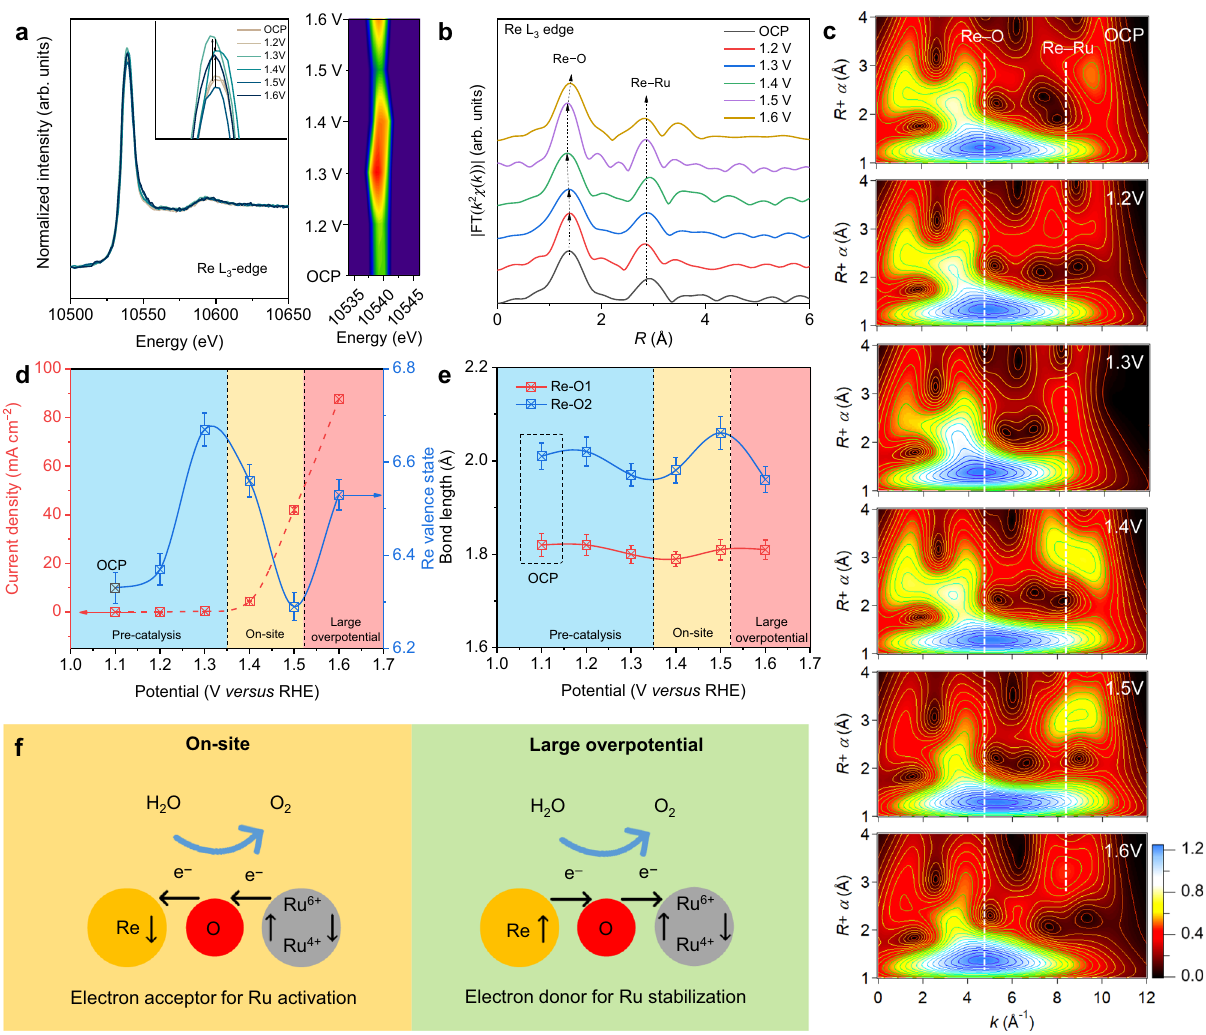
Fig. 3 | Operando XAS characterization of Re 0.06 Ru 0.94 O 2 con fi rming dynamic process. a Re L 3 -edge XANES spectra for Re 0.06 Ru 0.94 O 2 at differing potentials in O 2 -saturated 0.1M HClO 4 . Right part: contour plot of the Re L 3 -edge white peak intensity. b FT-EXAFS signals for Re 0.06 Ru 0.94 O 2 corresponding to ( a ). c Comparison of Re L 3 -edge WT-EXAFS plots for Re 0.06 Ru 0.94 O 2 from OCP to 1.6V. d Change in Re valence state and OER current as a function of applied potential.